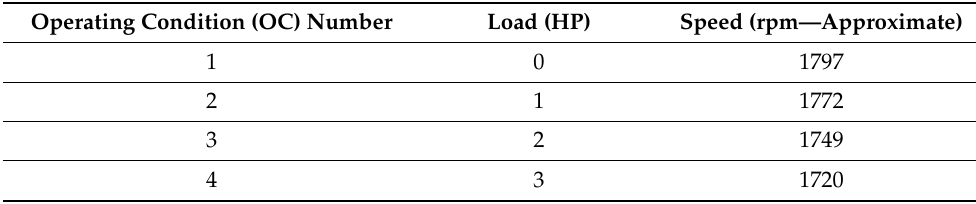
Table 1. Different operating